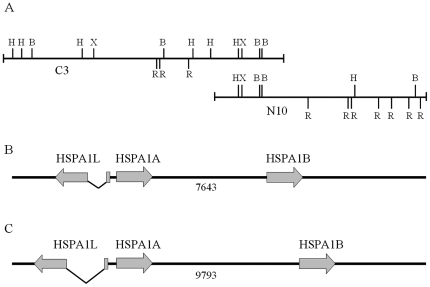
General organization of the hsp70 cluster in camel and human.A – restriction maps of two overlapping recombinant phages, C3 and N10, used in the analysis (H – HindIII, X – XhoI, R – EcoRI, B – BamHI). B – general structure of the C. dromedarius HspA1 cluster. C – general structure of H. sapiens HSPA1 cluster provided for comparison. The length of the intergenic region between hspA1A and hspA1B genes is given in bps.